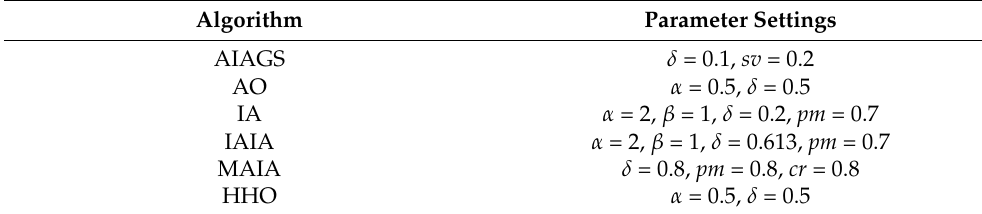
Table 2. Parameter settings.